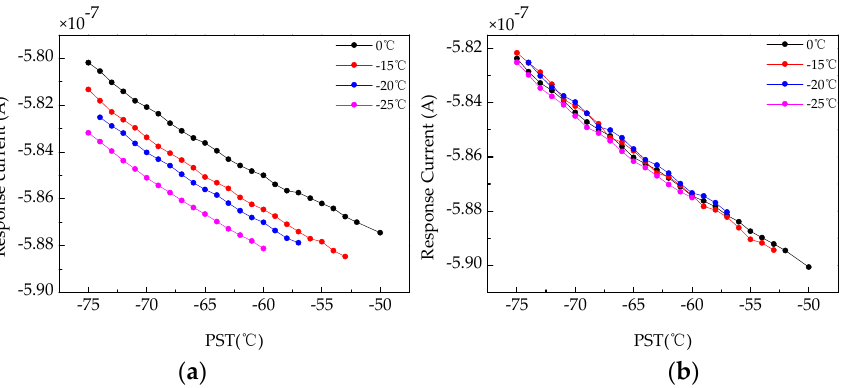
Figure 14. Detector response current temperature curves at four heat sink temperatures: ( a ) before F fil (t) correction; ( b ) after F fil (t) correction.